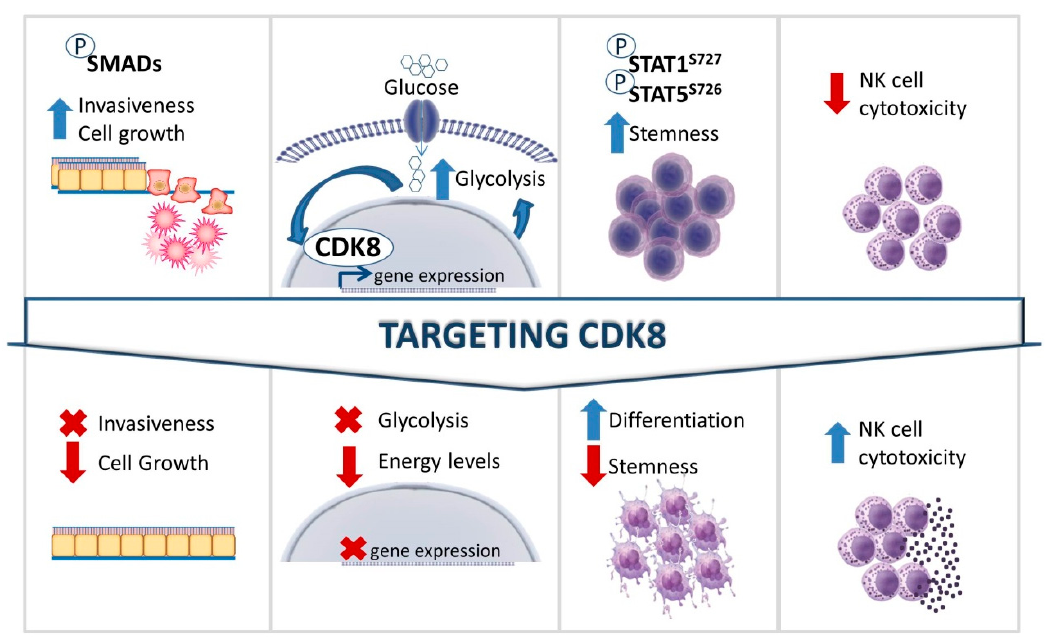
Figure 3. Potential therapeutic benefits of targeting CDK8 in cancer. Oncogenic functions of CDK8 are depicted in the upper panel. The lower panel shows the predicted outcomes upon targeting CDK8.